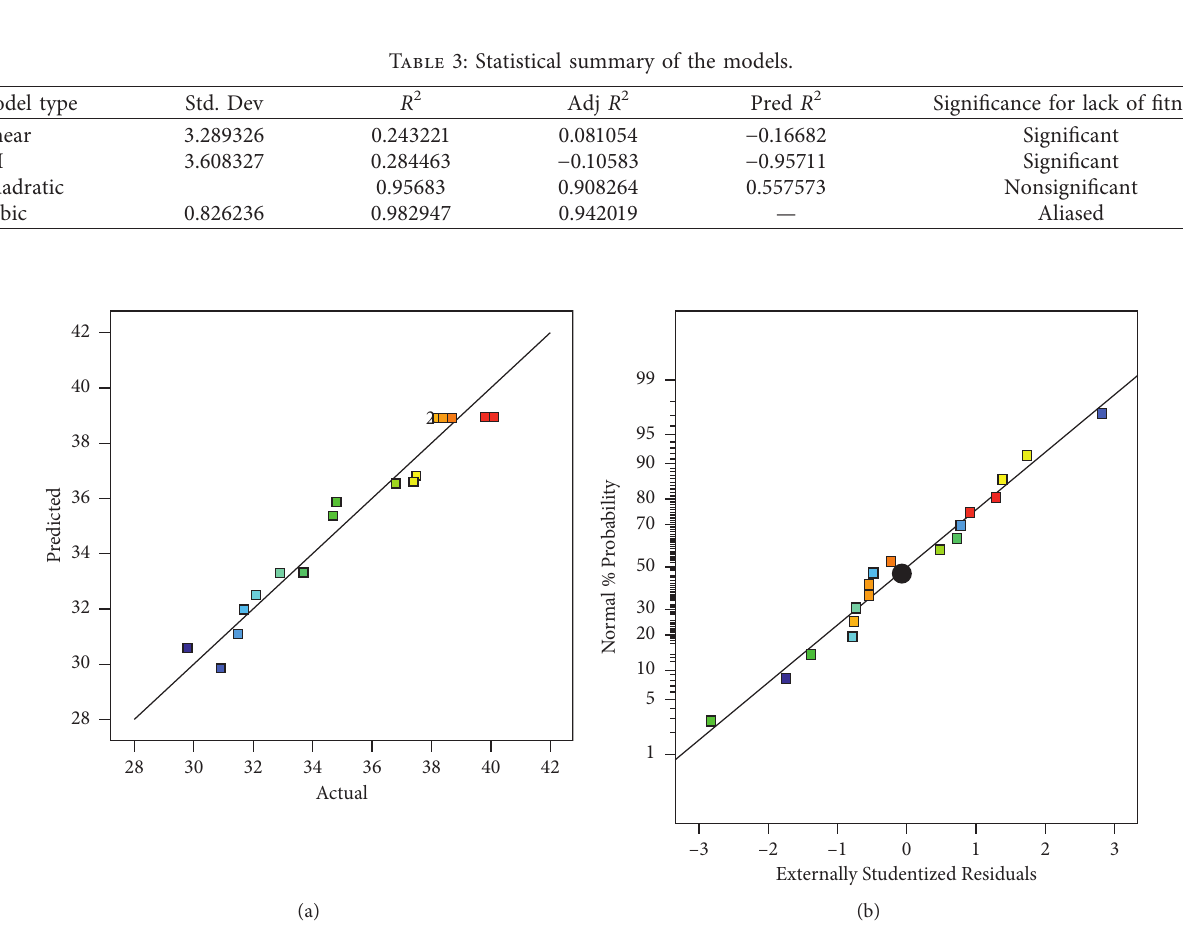
Figure 2: Analytical plots for adequacy of the proposed model. (a) Actual versus predicted plot. (b) Normal plot of